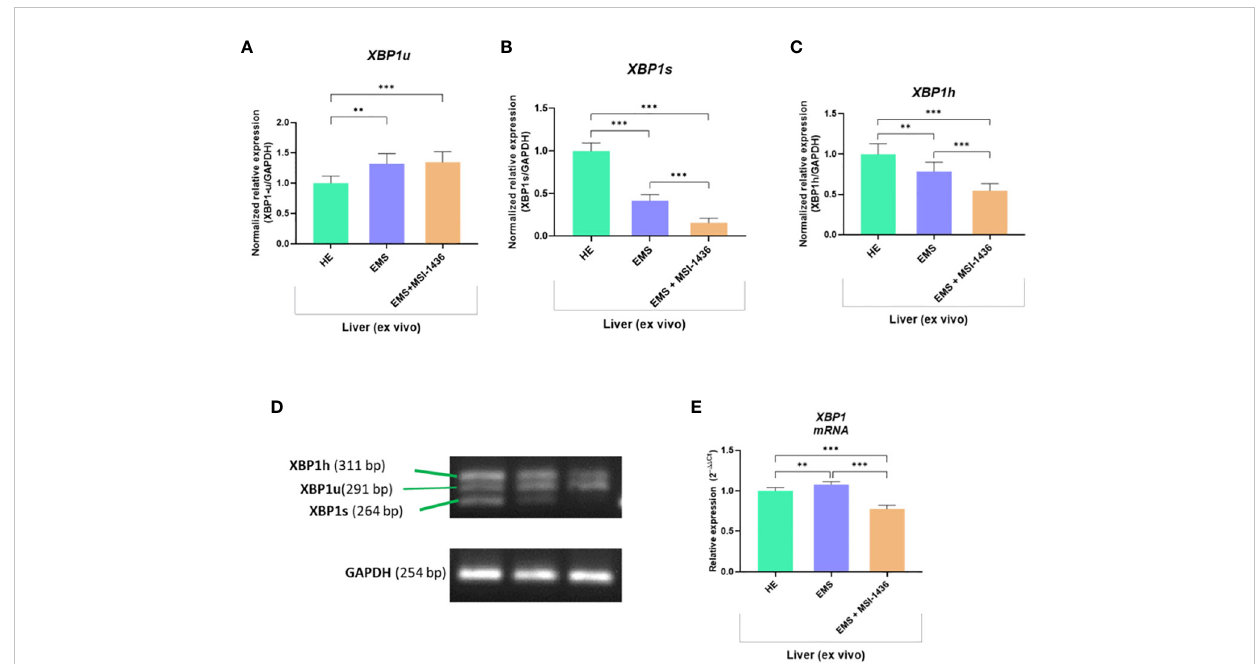
FIGURE 2 The expression of XBP1 and analysis of its splicing. The densitometric analysis of single-stranded cDNA annealed to double-stranded XBP1 unspliced ( XBP1 u; A, D ) and spliced XBP1 ( XPB1s ; B, D ), as well as hybrid ( XBP1h ) formed from one strand XBP1u and one strand XBP1s (C, D) . The number of accumulated XBP1 transcripts was determined using RT-qPCR (E) . All results are shown as mean ± SD. Columns with bars represent means ± SD. **p<0.01; ***p-value <